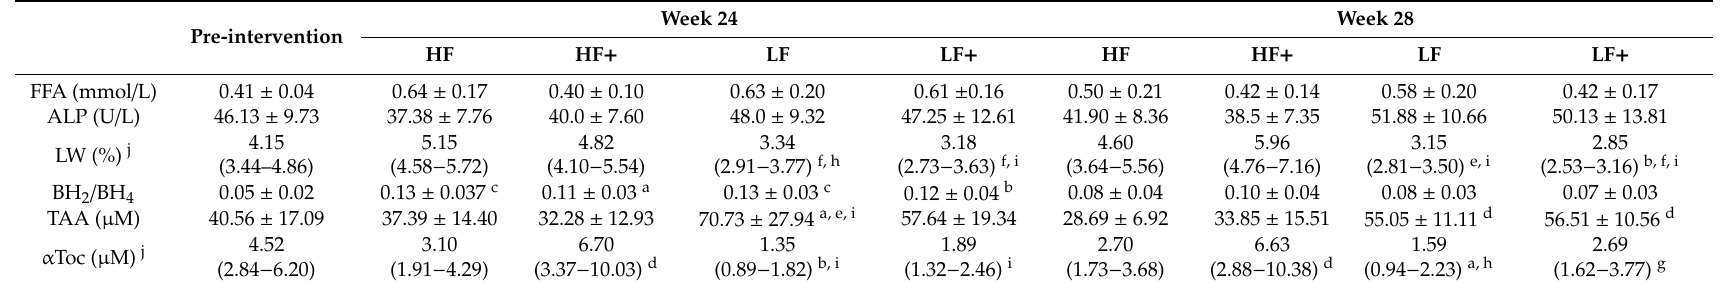
Table 3. Plasma values at Pre-intervention, Week 24 and Week 28.